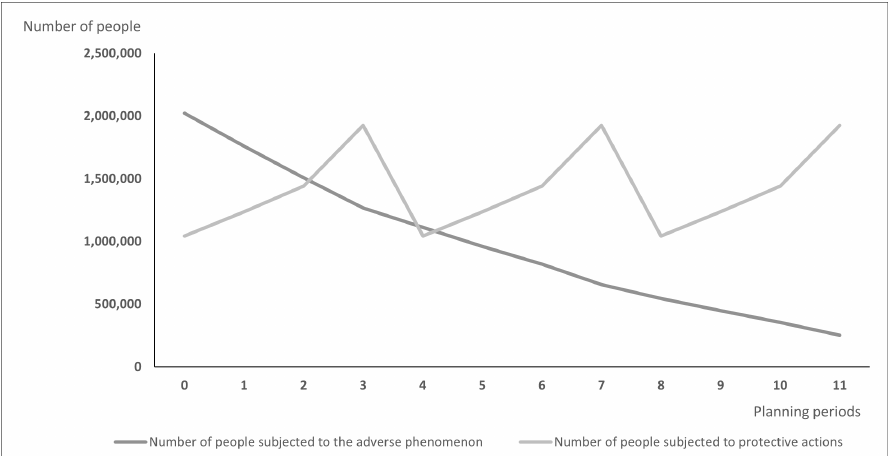
Figure 2. The results obtained using the PDPAHIT model for the entire